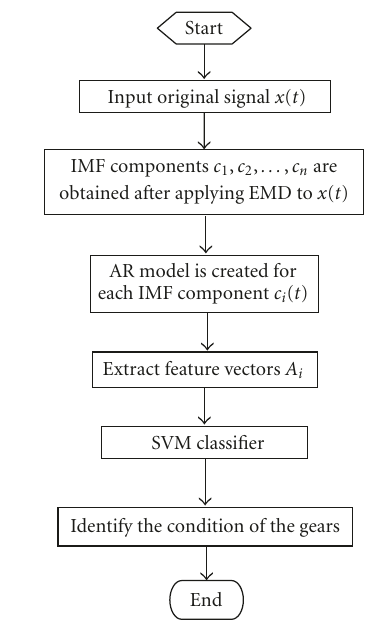
Figure 4: The flow chart of the proposed